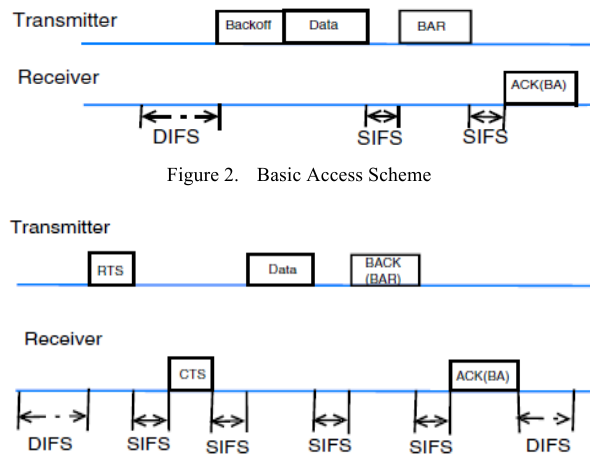
Figure 2. Basic Access Scheme